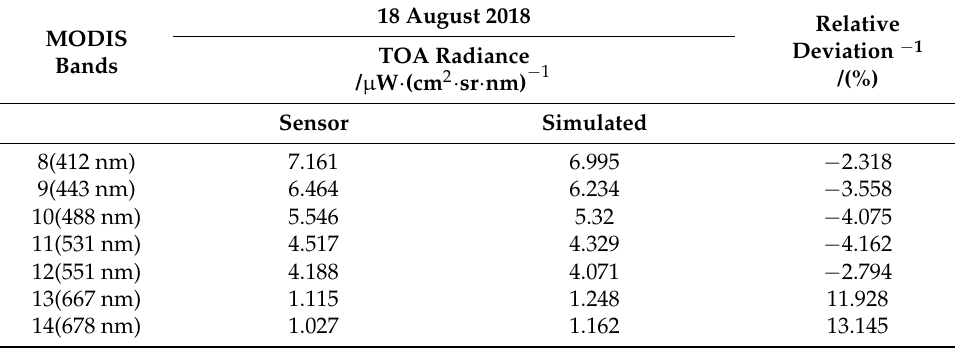
Table 6. Comparisons of TOA radiance between simulated and Aqua/MODIS measured.